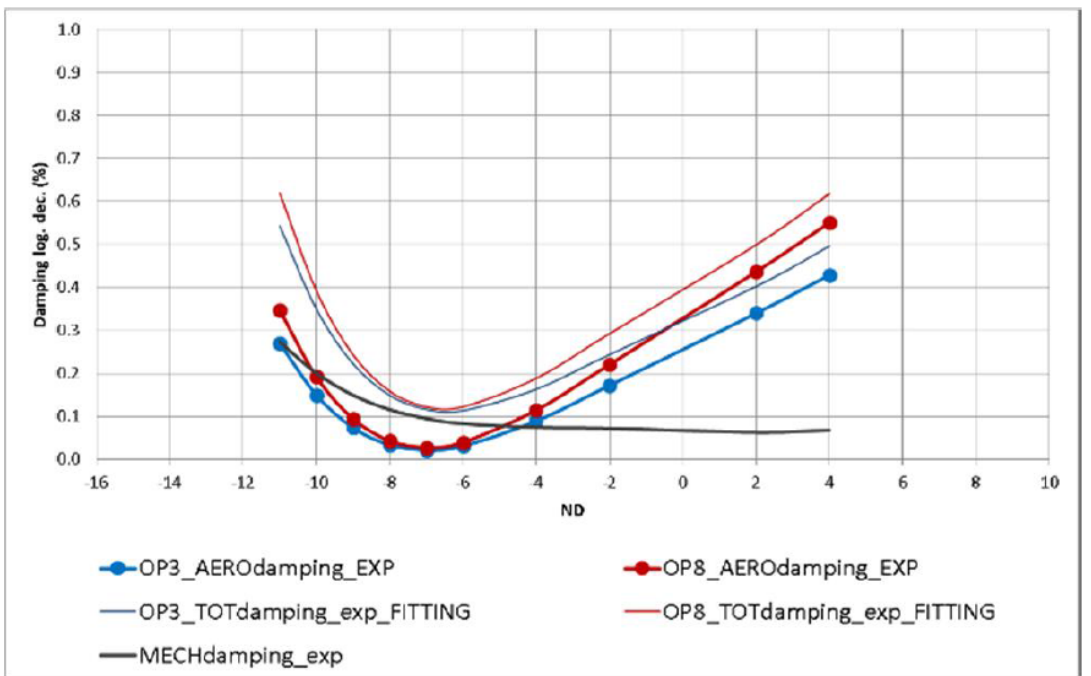
Figure 15. Separation of mechanical and aerodynamic contributions for OP3 and OP8, from aggregated damping